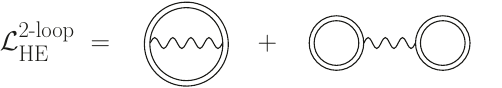
2-loop 2-loop 2-loop = + . The double solid line HE 1PI 1PR L L L